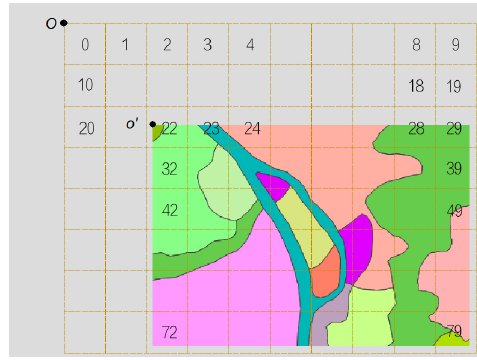
Figure 3. Local map area locating in a global tile map grid.